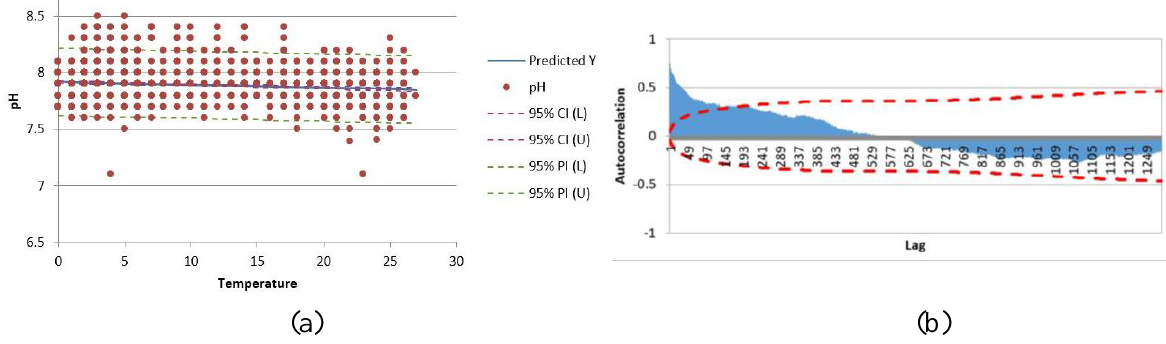
Figure 9. pH and temperature: (a) Scatter plot рН vs. Temperature, (b) Autocorrelation function (with limited significance) for pH in the range of 365